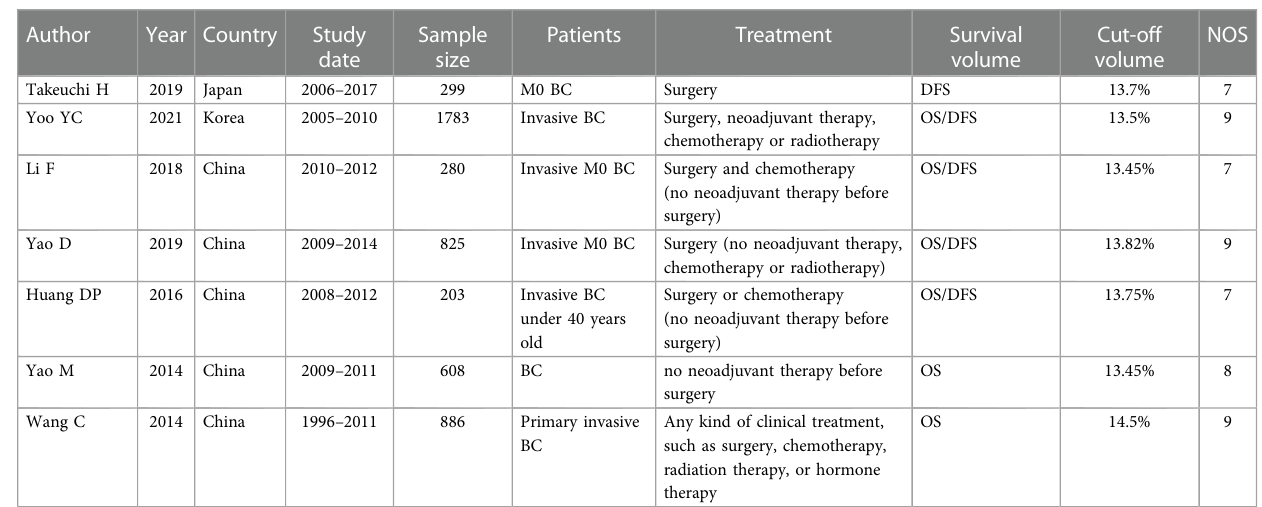
TABLE 1 Baseline characteristics of included